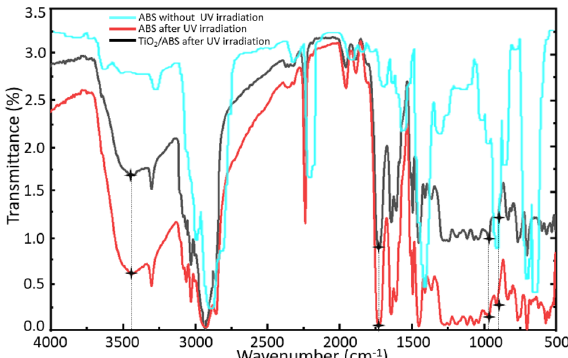
Figure 9. FTIR spectra of an ABS film without UV irradiation, an ABS film after UV irradiation for 200 h and a TiO 2 /ABS film after UV irradiation for 200